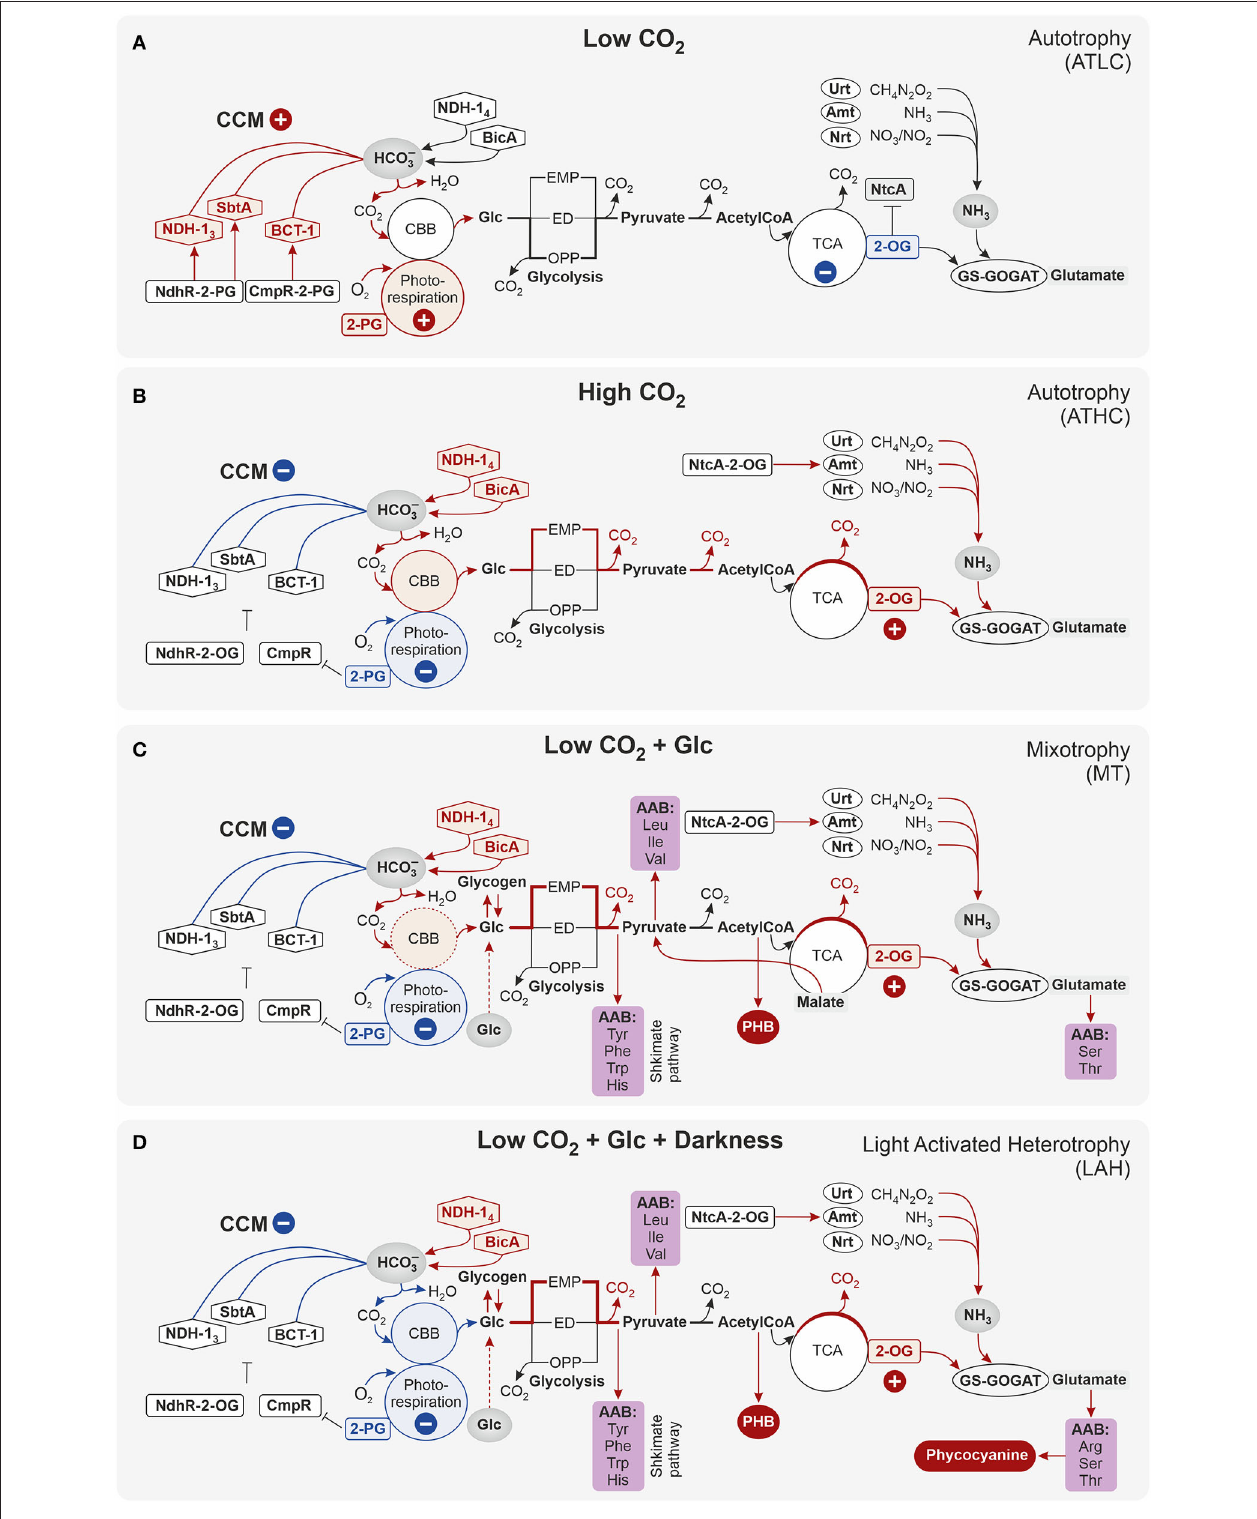
FIGURE 5 | Schematic representation of the regulation of carbon metabolism in Synechocystis sp. PCC 6803 cells grown under (A) low-carbon autotrophy (ATLC) and (B–D) carbon-rich ATHC (B) , MT (C) , LAH (D) conditions. The main sensors of carbon availability in the cells are 2-phosphoglycolate (2-PG), the product of photorespiration, and 2-oxoglutarate (2-OG), an intermediary product in TCA cycle. In low CO 2 autotrophy (ATLC), 2-PG is typically at high level together with CCM